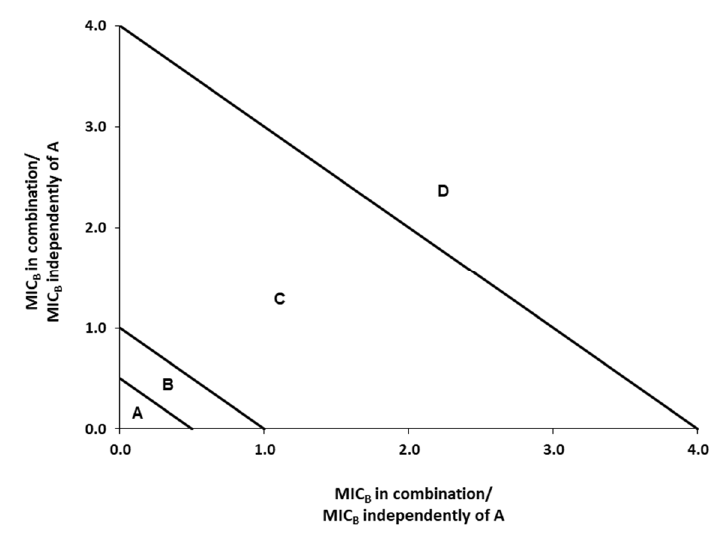
Figure 1. Interpretation of an isobologram. Depending on the area where the CIF values of the mixture are located, the effect is A: synergistic, B: additive, C: indifferent, or D: antagonistic [28].